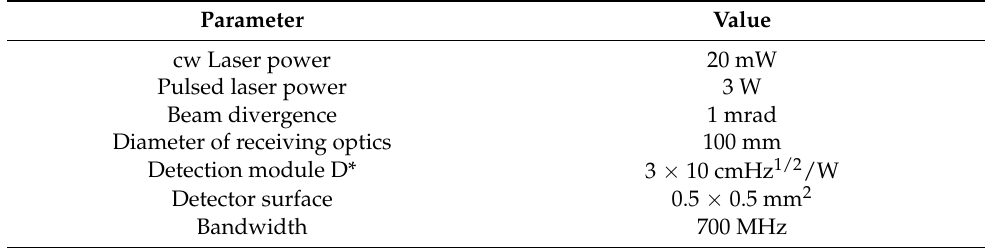
Table 5. Parameters of the FSO components.